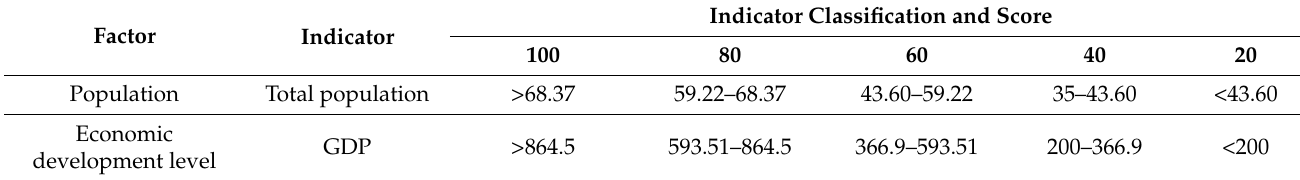
Table 5. Human needs diversity evaluation index